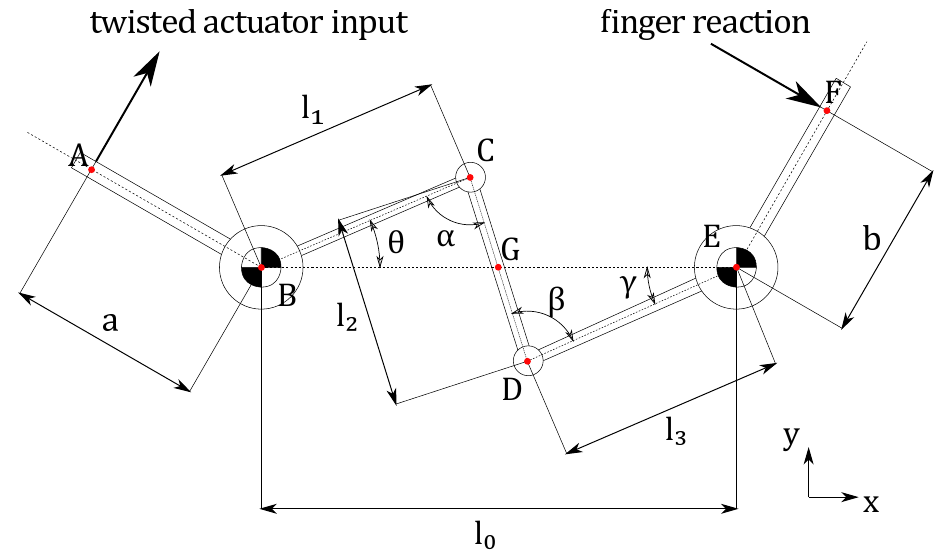
Figure 2. Simplified transmission kinematics. Flexure hinges are modeled as rotary